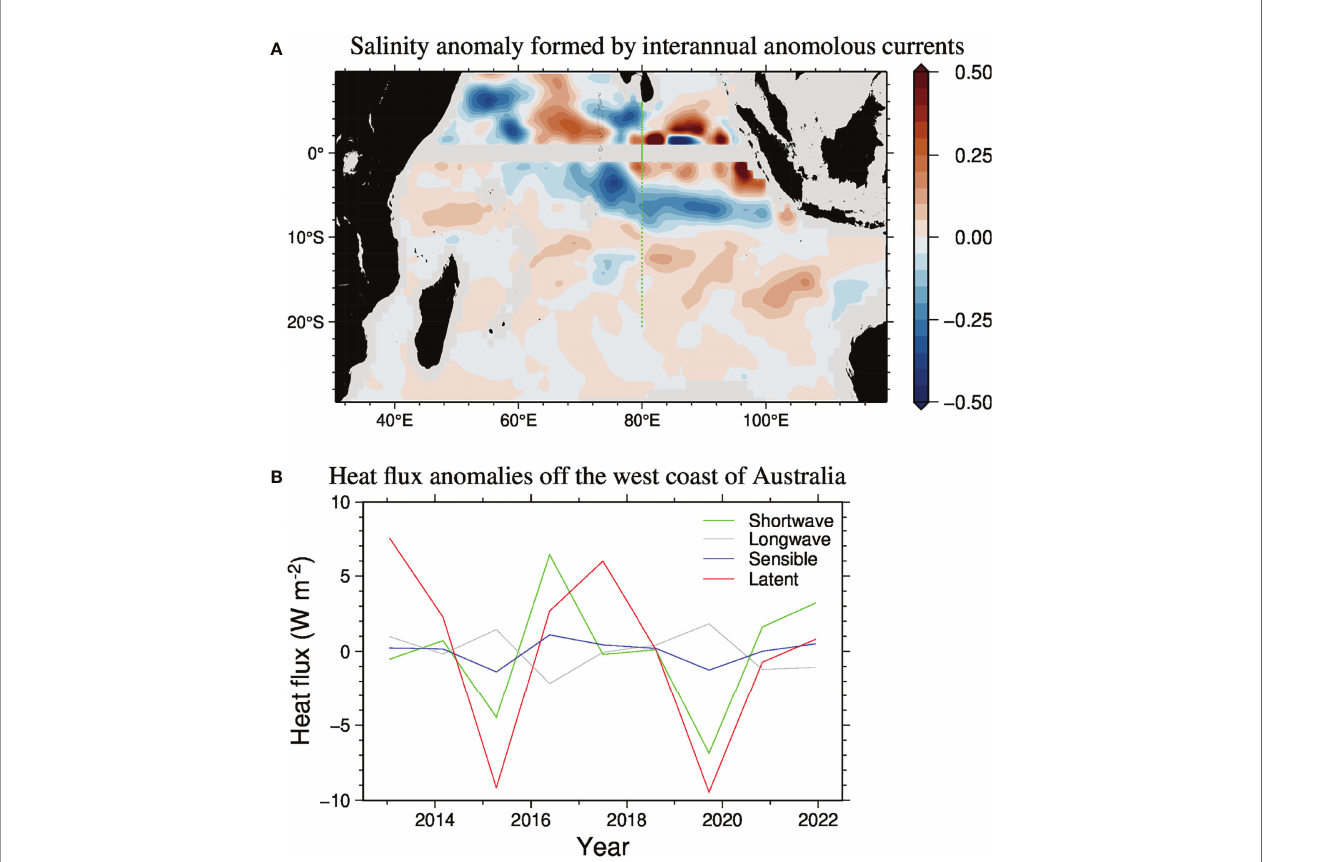
FIGURE 12 | (A) Estimated salinity anomalies on 25.0 g based on the Argo gridded dataset, which could be formed by interannual seasonal anomalous currents from August 2019 to December 2019. (B) Annual-mean surface heat fl ux anomalies averaged over 15°-27.5°S, 80°-115°E from the long-term mean (2013-2021) for shortwave radiation (green), longwave radiation (gray), sensible heat fl ux (blue), and latent heat fl ux (red), based on ERA5 data (Hersbach et al., 2019).